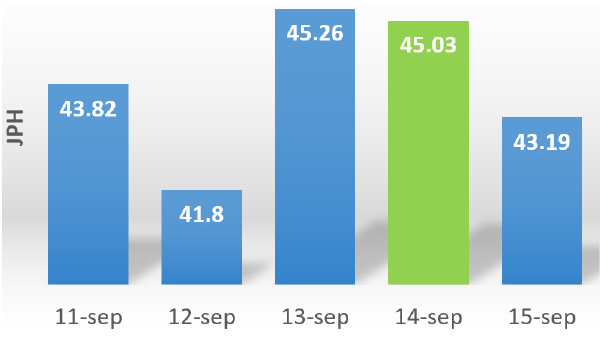
Figure 15. Velocity percentages for each station.